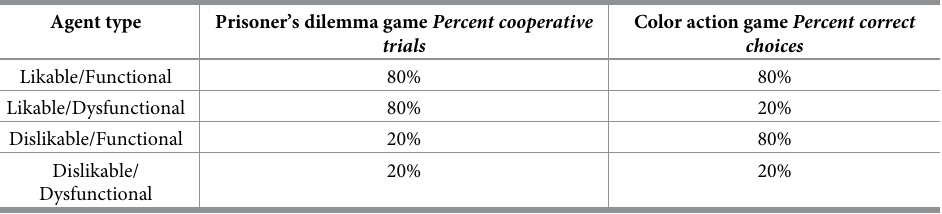
Table 2. Behavioral characteristics per agent in experiment